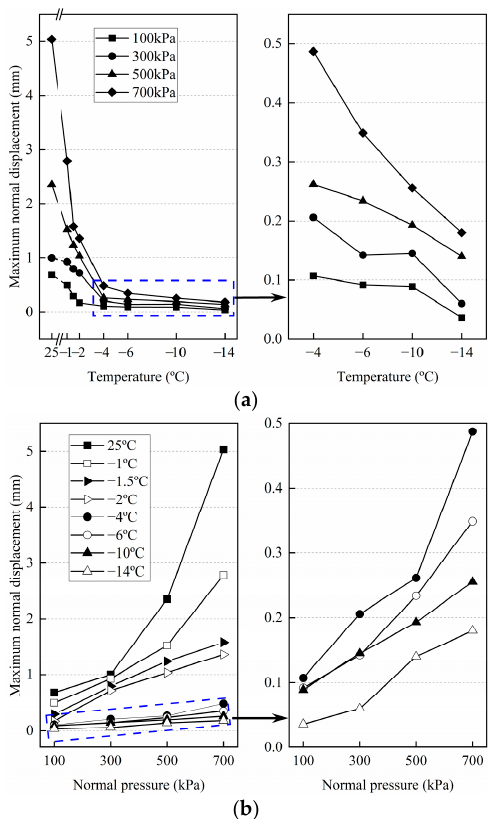
Figure 14. Variation of the maximum normal displacement in various conditions. ( a ) with temperature; ( b ) with normal stress. The relationship between the maximum normal displacement of frozen cement- treated sand and temperature under four normal stresses is fitted. The fitted regression equation is given as follows: